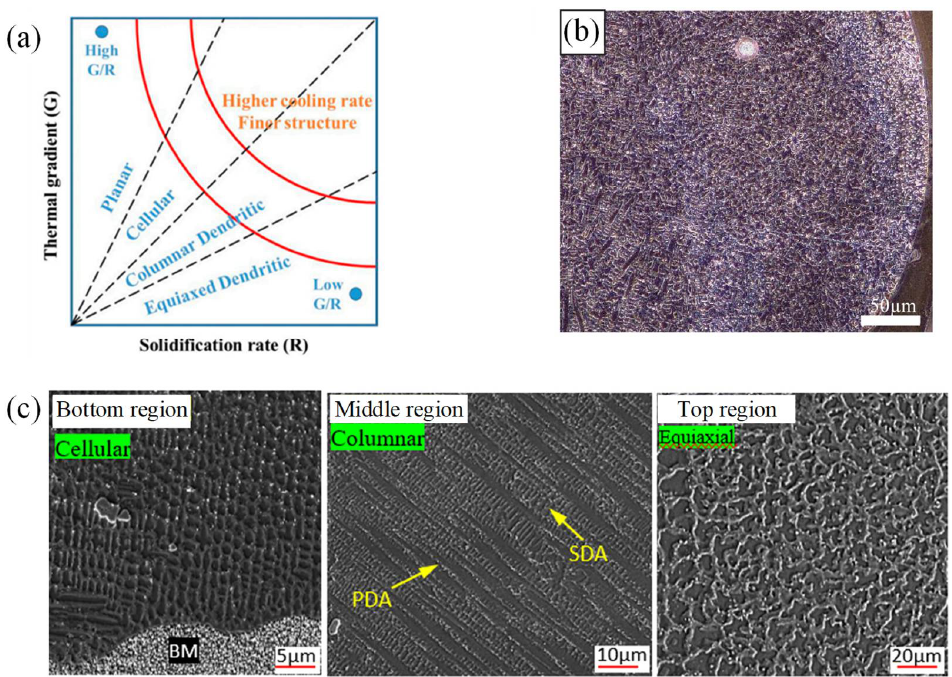
Figure 4. ( a ) Solidification map established by solidification parameters (Reprinted from ref. [72], copyright (2021), with permission from Elsevier); ( b ) Evolution of grain structure of IN625 thin-wall from columnar (core/interfacial), large equiaxed grains (transition), to small equiaxed grains (surface) (Reprinted from ref. [74], copyright (2020), with permission from Elsevier); ( c ) Evolution of grain structure of IN625 thin-wall from cellular (bottom region), columnar (middle region), to equiaxed grains (top region) (Reprinted from ref. [73], copyright (2020), with permission from Elsevier). For example, Xue et al. pointed out that the sub-grain size of the bottom, middle, and